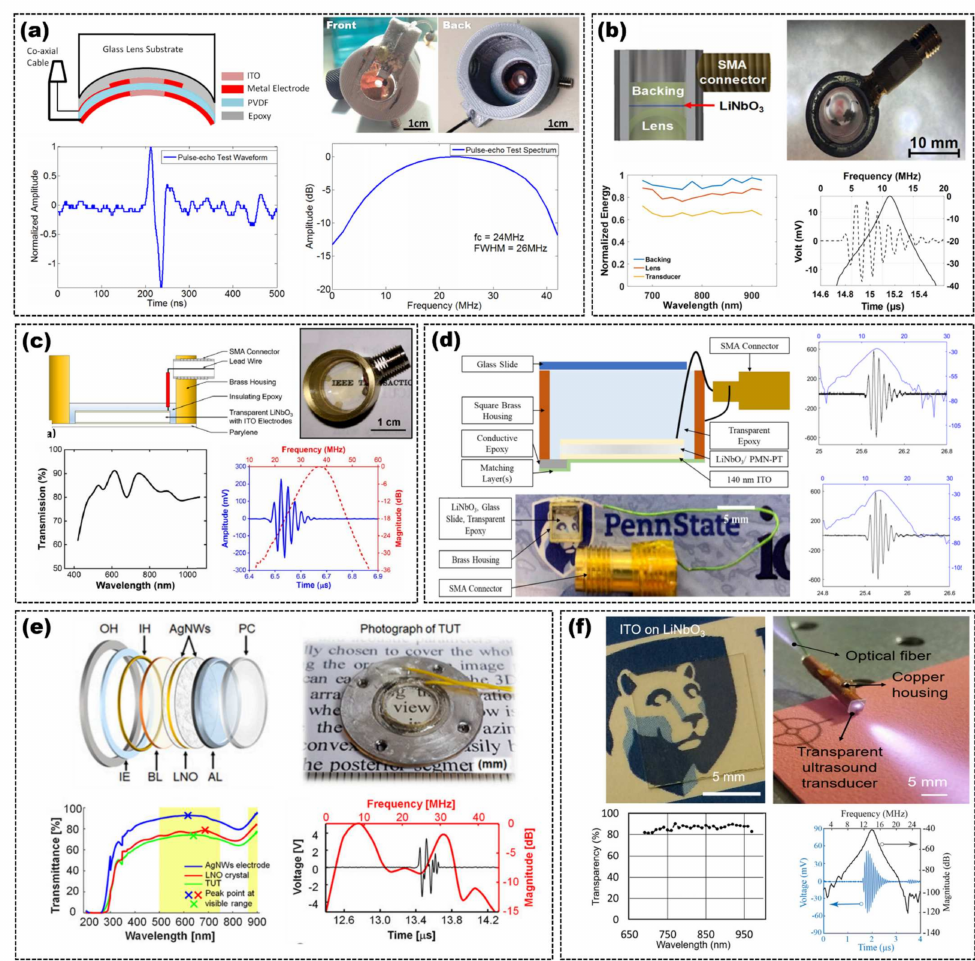
Figure 2. Transparent piezoelectric-based US sensors: ( a ) Schematic (upper left), photography (upper right), pulse-echo waveform (lower left), and spectrum (lower right) of a 24 MHz PVDF focused transparent sensor design. PVDF: Poly(vinylidene fluoride), ITO: Indium tin oxide. Adapted with permission from ref. [26]. Copyright 2020 Institute of Electrical and Electronics Engineers; ( b ) Schematic cross section (upper left), photograph (upper right), light attenuation occurring after penetrating each acoustic layer (lower left), and pulse-echo response and its frequency spectrum (lower right) of a 11.2 MHz LN optically transparent focused US sensor. Adapted from ref. [60]; ( c ) Design cross section (upper left), photograph (upper right), optical transmittance (lower left), and pulse-echo response and its frequency spectrum (lower right) of a 37 MHz LN high-frequency transparent US sensor. Adapted with permission from ref. [31]. Copyright 2020 Institute of Electrical and Electronics Engineers; ( d ) Schematic (upper left), photograph (lower left), pulse echo responses of DC poled (upper right) and AC poled (lower right) PMN-PT US sensors (14 MHz). Adapted with permission from ref. [61]. Copyright 2010 Woodhead Publishing; ( e ) Schematic layer-by-layer illustration (upper left), photograph (upper right), light transmittance (lower left), and pulse echo response and frequency spectra (lower right) of a dual center frequencies (~7.5 and ~31.5 MHz) transparent LN US sensor. PC: personal computer, AL: acoustic lens, LNO: lithium niobite, AgNWs: silver nanowires, BL: backing layer, IH: inner housing, IE: insulation epoxy, OH: outer housing, TUT: transparent ultrasound transducer. Adapted with permission from ref. [32]. Copyright 2021 Proceedings of the National Academy of Sciences of the United States of America; ( f ) A 14.5 MHz transparent PMN-PT US sensor: Picture of an optically transparent LN substrate coated with ITO (upper left), picture of a 2.5 mm × 2.5 mm sensor integrated with an optical fiber (upper right), optical transparency of the ITO-coated LN (lower left), and pulse-echo response of the sensor. Adapted with permission from ref. [30]. Copyright 2019 Optical Society of